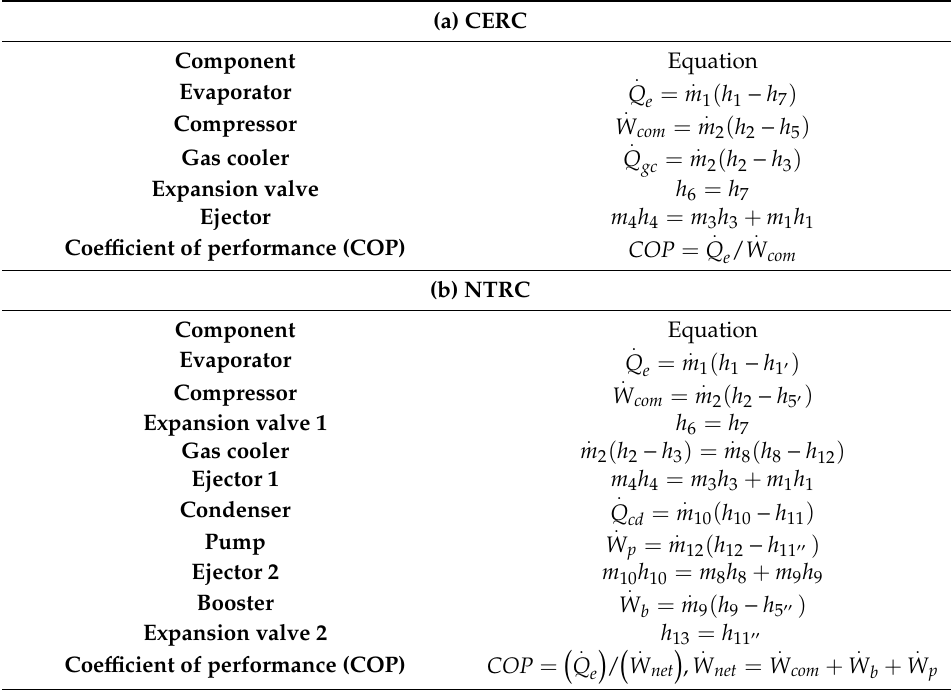
Table 2. Thermodynamic and energy balance equations for CERC and